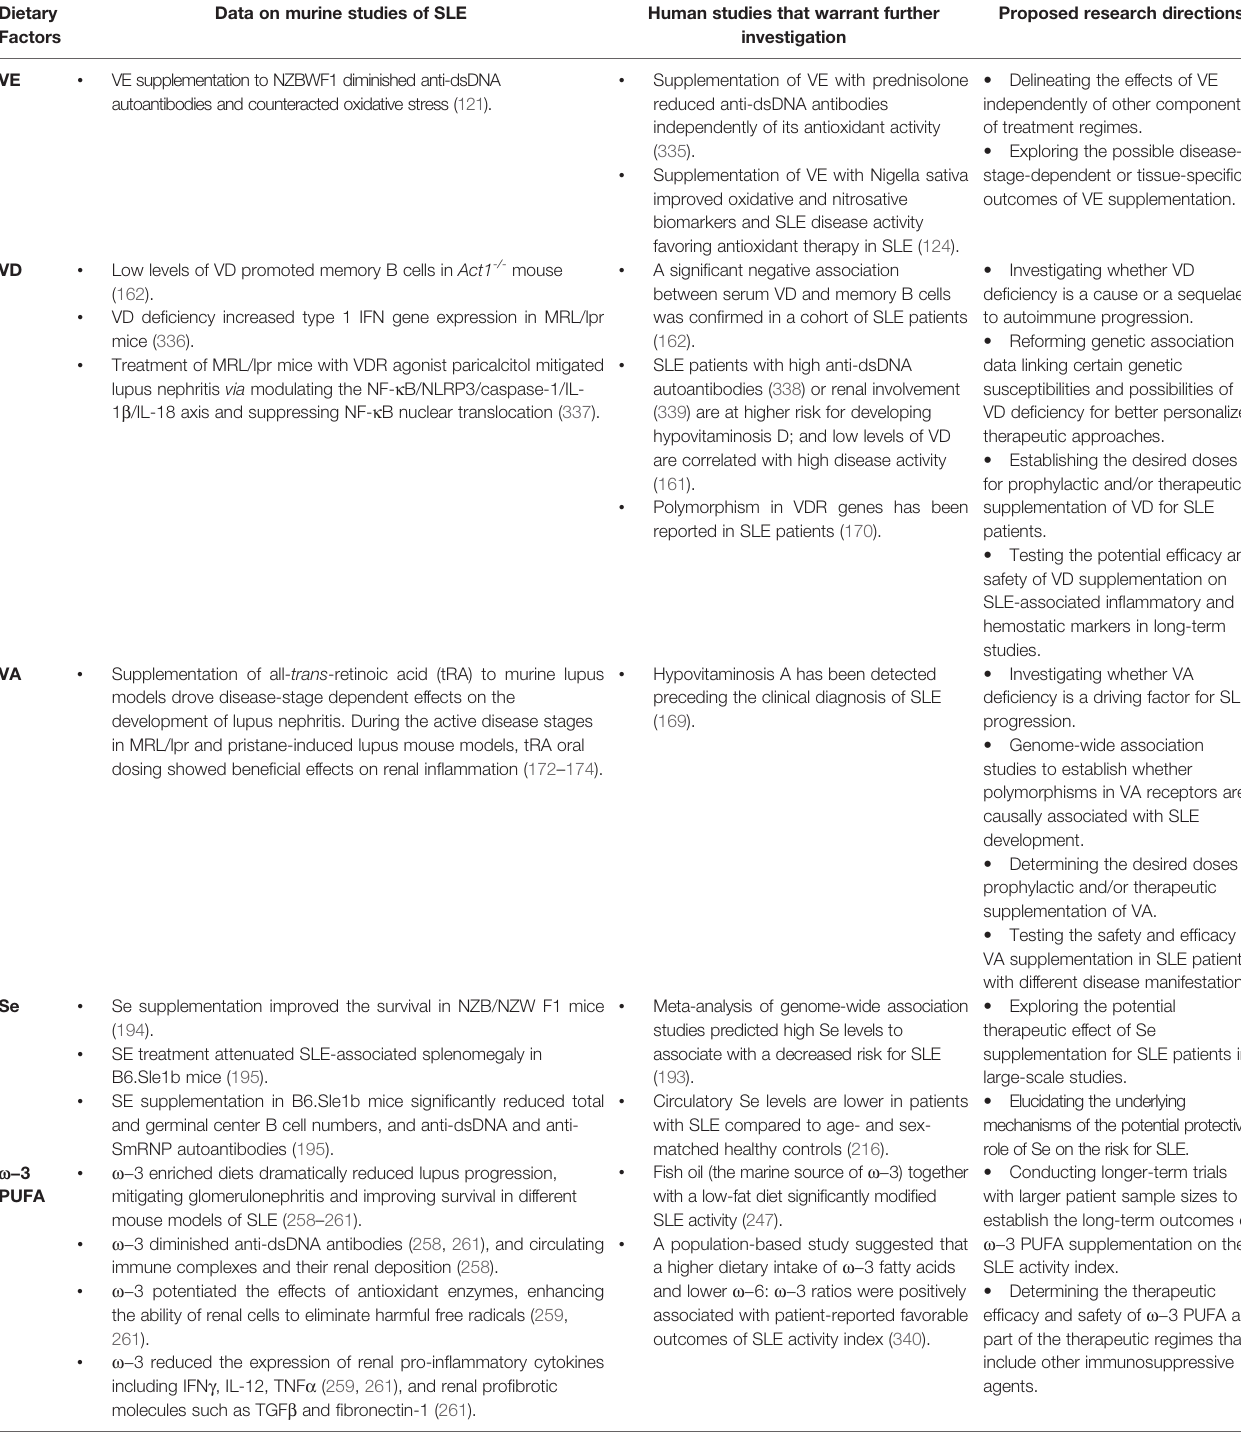
TABLE 1 | The positive in fl uence of speci fi c dietary nutrients on SLE. Dietary